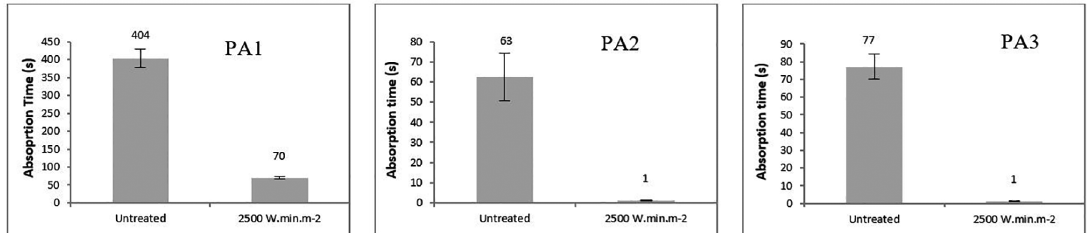
Figure 1. Water drop adsorption time for untreated and plasma treated samples (2500 W.min.m -2 ).